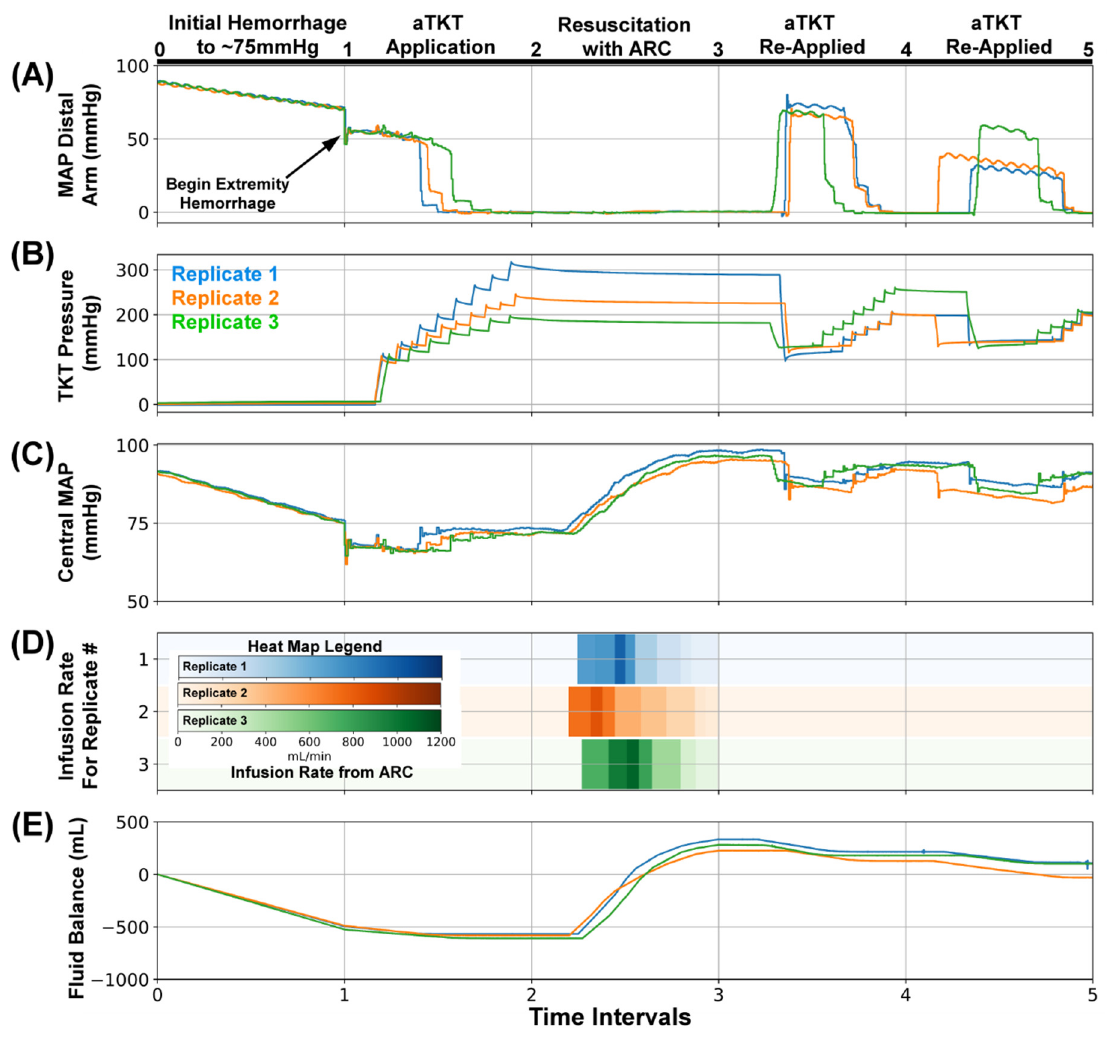
Figure 6. SACM Testing Scenario #2. After (0–1), the initial hemorrhage reduced blood pressure to approximately 75 mmHg, (1–2) extremity hemorrhage was stopped by the aTKT, (2–3) and resuscitation restored pressure to 95 mmHg by ARC. Next, (3–4) tourniquet cuff pressure was slightly reduced to mimic loosening, which was detected by SACM and re-inflated by aTKT; (4–5) a similar tourniquet loosening was repeated afterwards. Aligned results are shown for ( A ) MAP distal to the bleed site (mmHg, PT2), ( B ) Tourniquet Cuff pressure (mmHg), ( C ) Central MAP (mmHg, PT1), ( D ) Resuscitation flow rate (mL/min), and ( E ) overall system fluid balance (Infused Volume—Hemorrhage Volume, mL). Three individual replicates are shown to illustrate the similarities and difference between each replicate run.